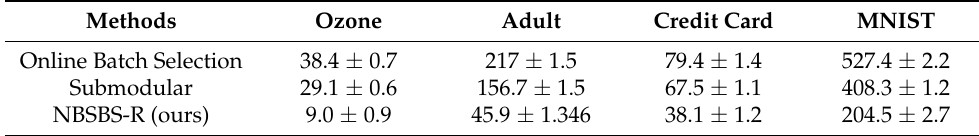
Table 11. Comparison of mean training times for each